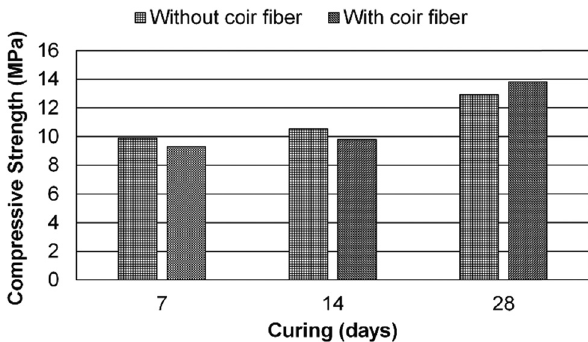
Figure 7: Compressive strength variation with curing